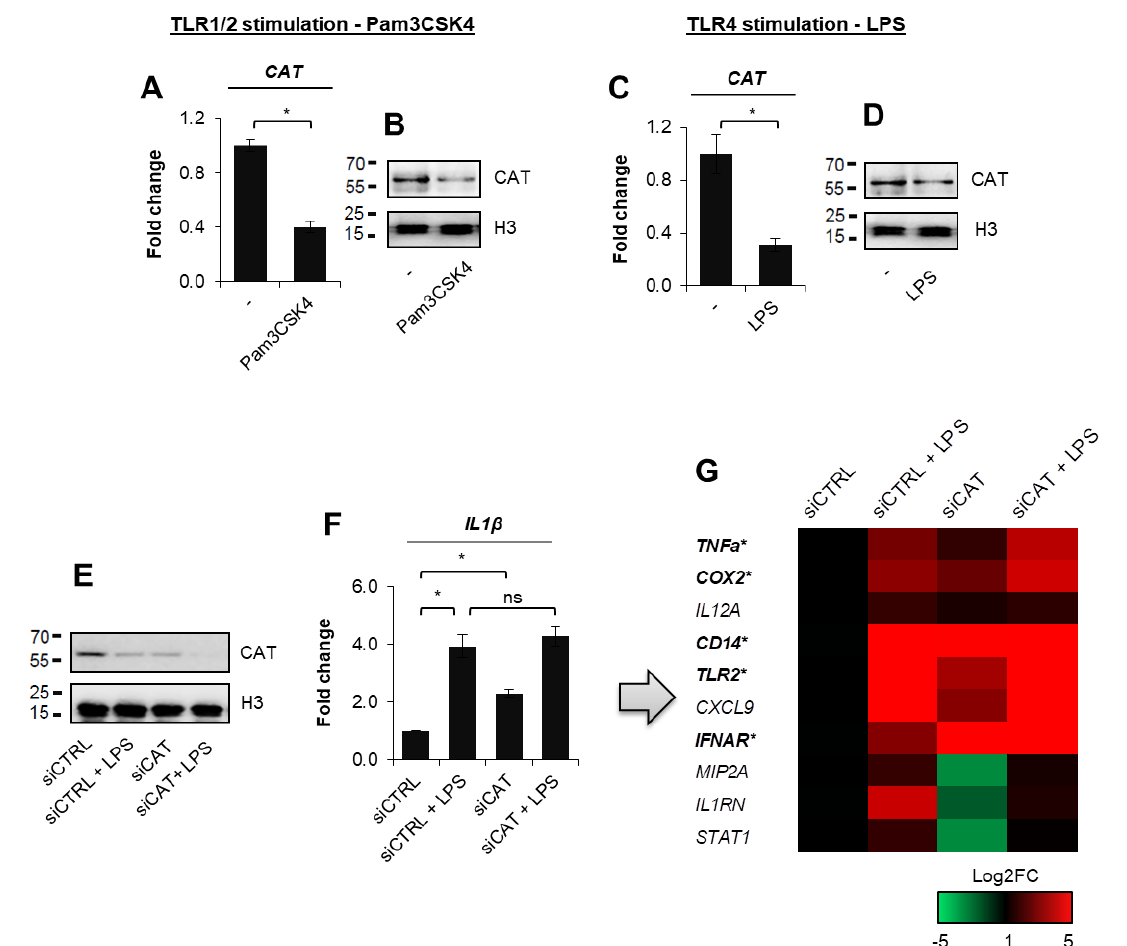
Figure 1. The decline in CAT total mRNA levels in human macrophages correlates with transcription of some macrophage pro-inflammatory markers. Granulocyte–macrophage colony-stimulating factor (GM-CSF)-differentiated human macrophages were quantified for CAT expression after their exposure to Pam3CSK4 (50 ng/mL; A and B) and LPS (10 ng/mL; C and D). mRNA level in ( A , C ) was measured by real-time PCR, while catalase protein in ( B , D ) was visualized by Western blot after 24 h of cell incubation with TLR ligands. To verify the possible effect of catalase deficiency on selected pro-inflammatory features, CAT was targeted with siRNA and the silencing was confirmed by Western blot vs. siRNA non-template control (siCTRL) 48 h after cell transfection ( E ). The mRNA level of M1 markers was quantified by real-time PCR and shown in bar chart for IL1 β as an example ( F ) and heat map for other genes ( G ). Bolded genes marked with the star represent these substantially repressed by catalase in non-polarized cells. Western blots show representative images from three independent experiments. Bars in the figures represent mean ± standard error of the mean (SEM). One-way analysis of variance (ANOVA) was carried out in GraphPad Prism 5 to compare means in several groups and the differences between each two groups were tested with the Tukey post hoc test (marked with * when p < 0.05, with ns when p >